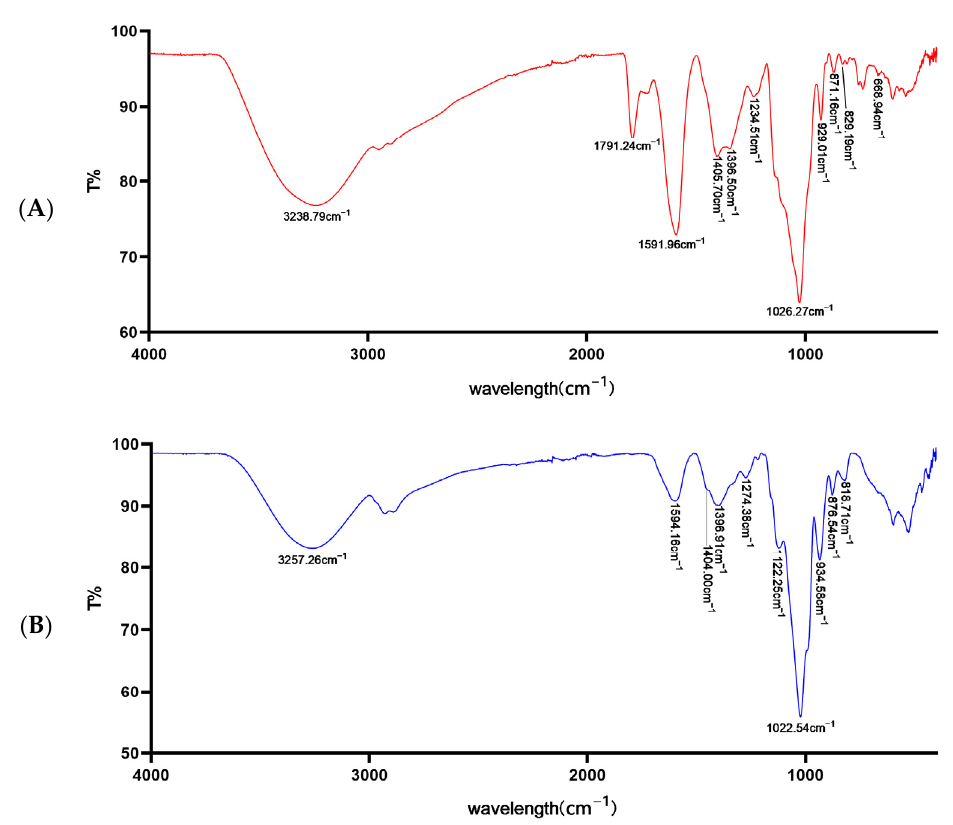
Figure 3. ATR-FTIR spectra of Se-MOP ( A ) and MOP ( B ) in the range of 4000–400 cm − 1 . The hori- zontal coordinate represents the wavelength (cm − 1 ). The vertical coordinate represents the transmit- tance (%).